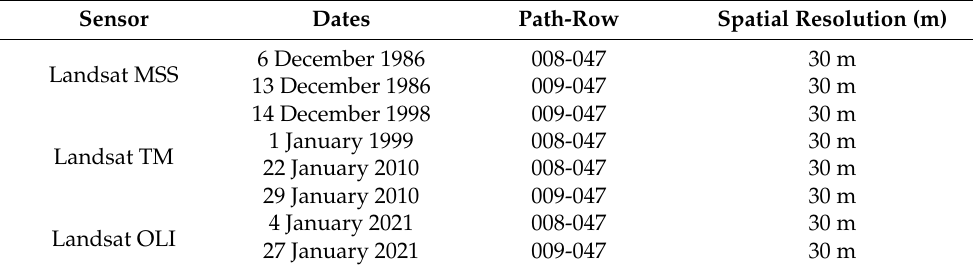
Table 2. Satellite images